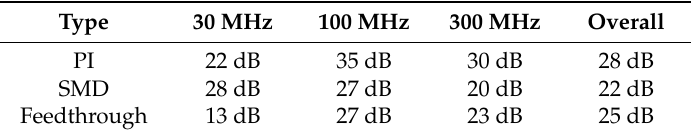
Table 2. Effective filter